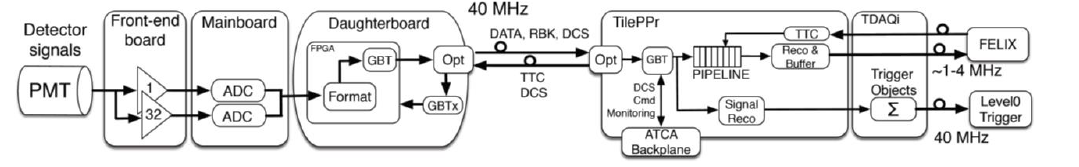
Fig.3. Block diagram of the HL-LHC readout architecture in